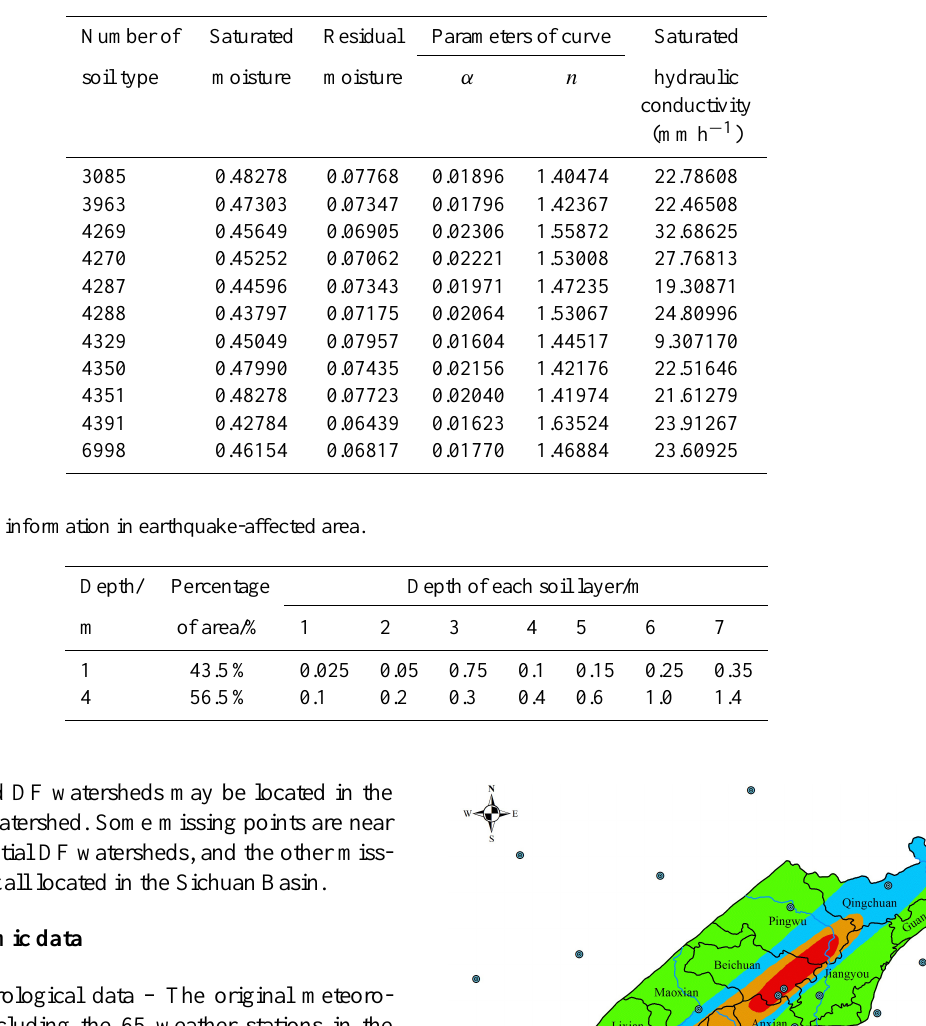
Table 3. The characteristic soil hydraulic parameters in the earthquake-affected area. Number of Saturated Residual Parameters of curve Saturated soil type